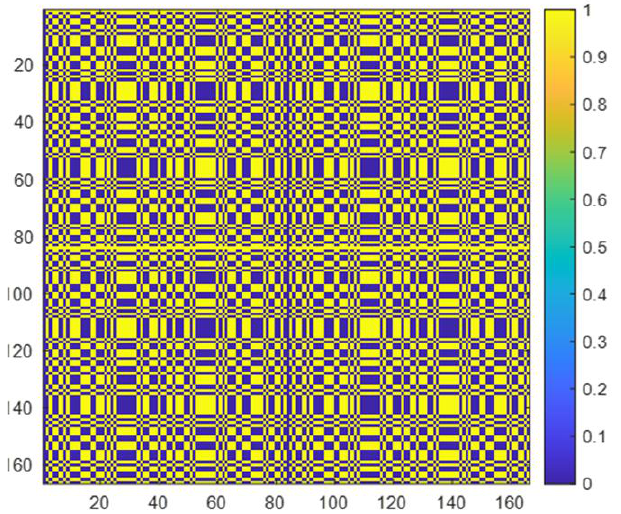
Figure 3. The mosaic MURA binary mask with 166x166 elements, blue color denotes o’s while yellow color denotes 1’s . The basic 83x83 MURA pattern was used to build this mosaic configura- tion.